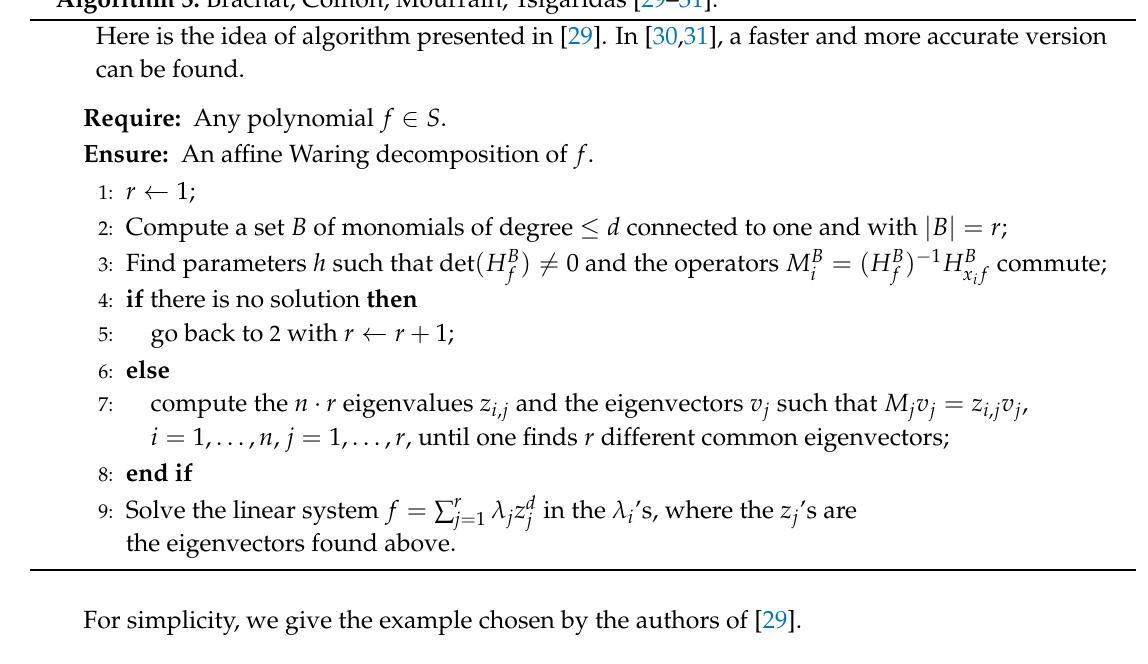
Algorithm 5: Brachat, Comon, Mourrain, Tsigaridas